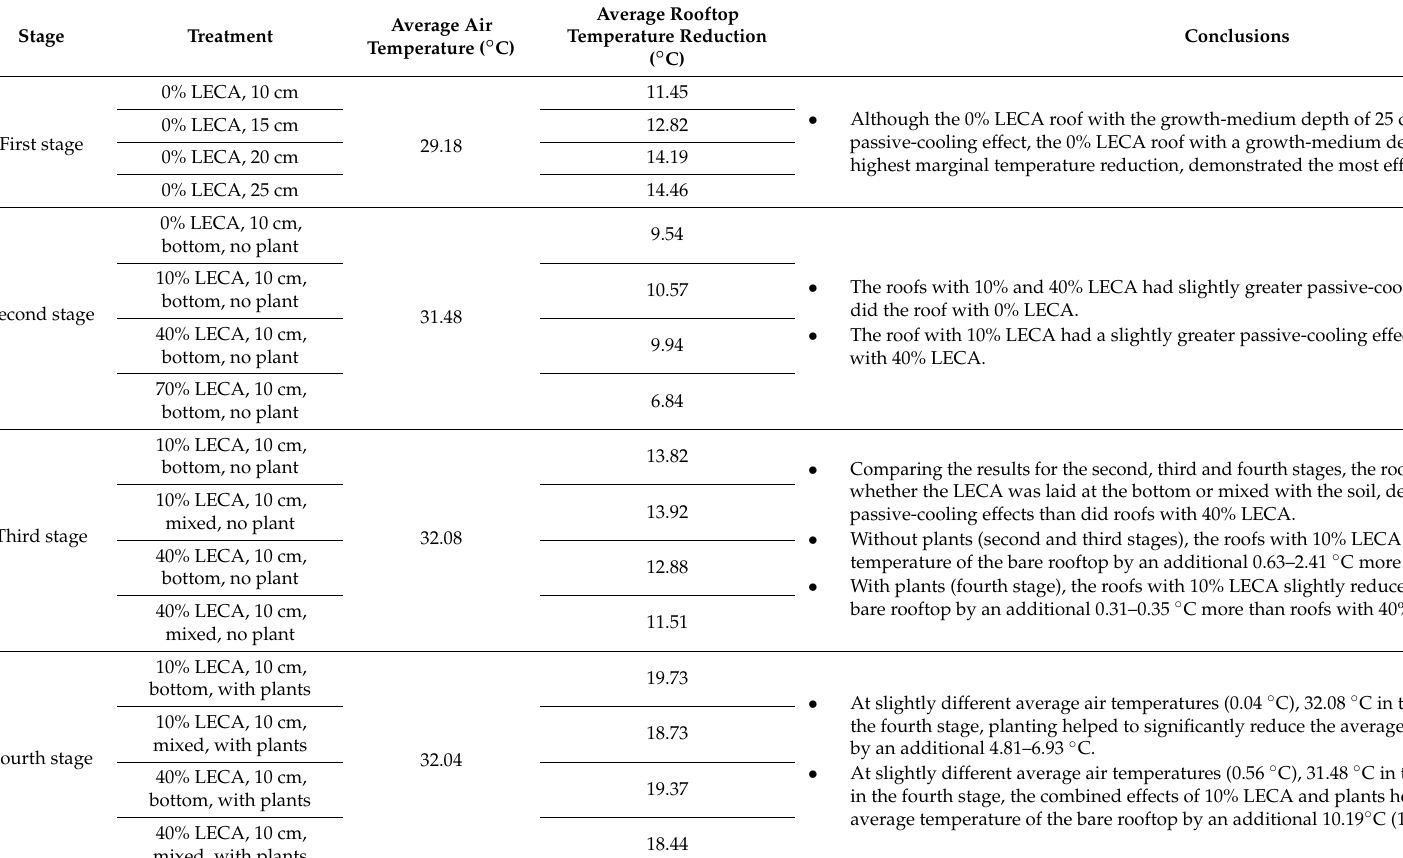
Table 14. Comparisons of the passive-cooling effects for four